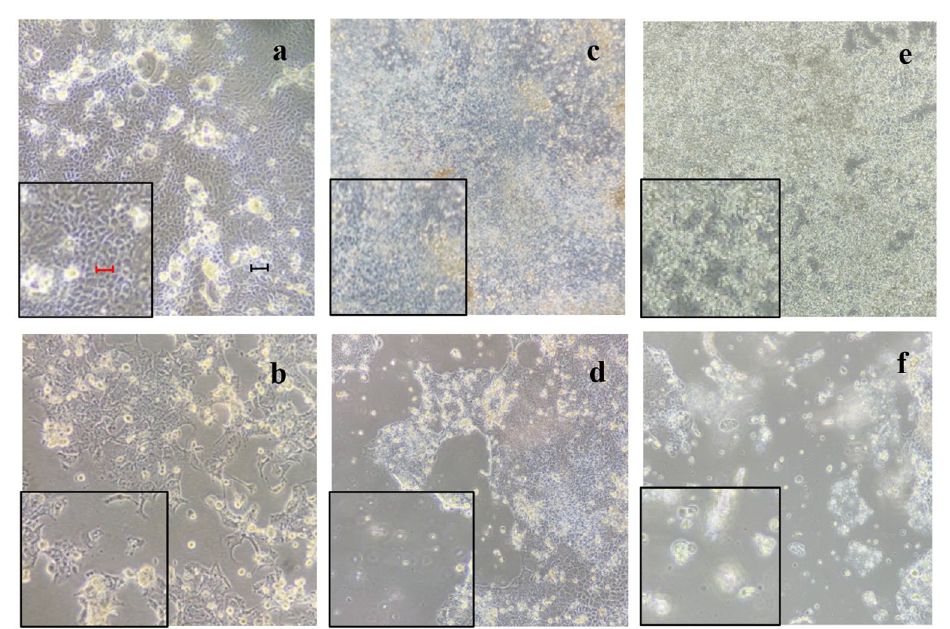
Figure 1. Structures of the investigated stilbenoids. For easier identification, the stilbenoids are numbered (see text for explanation).